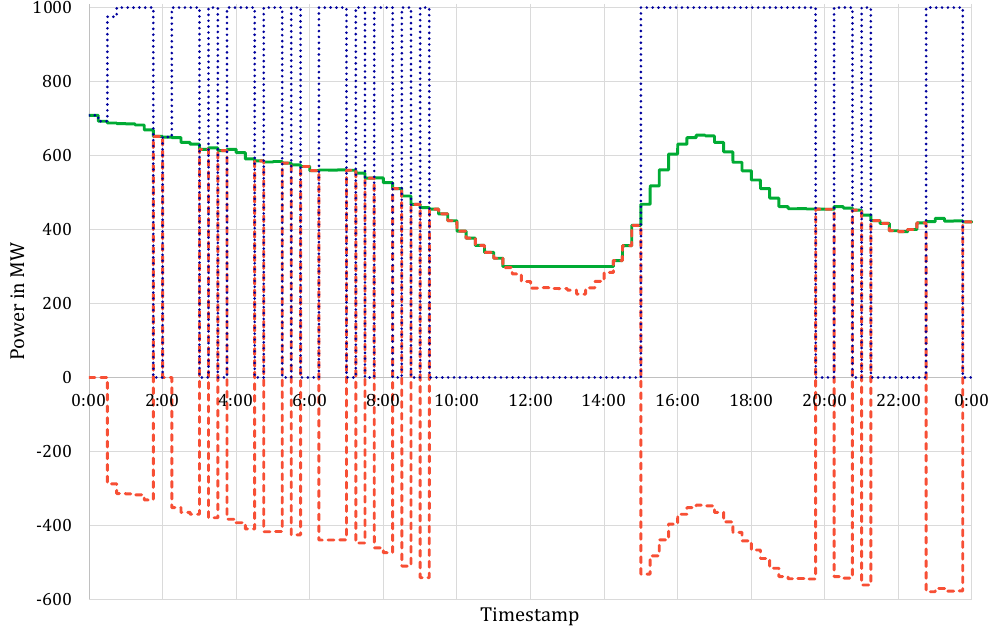
Figure 9. Time series excerpt of power of storages according to heuristic approach and UCO with 5 days interval on 17 January. 3000 MW each of VRE are installed. Short-term storage power of UCH is not shown, since it is zero.